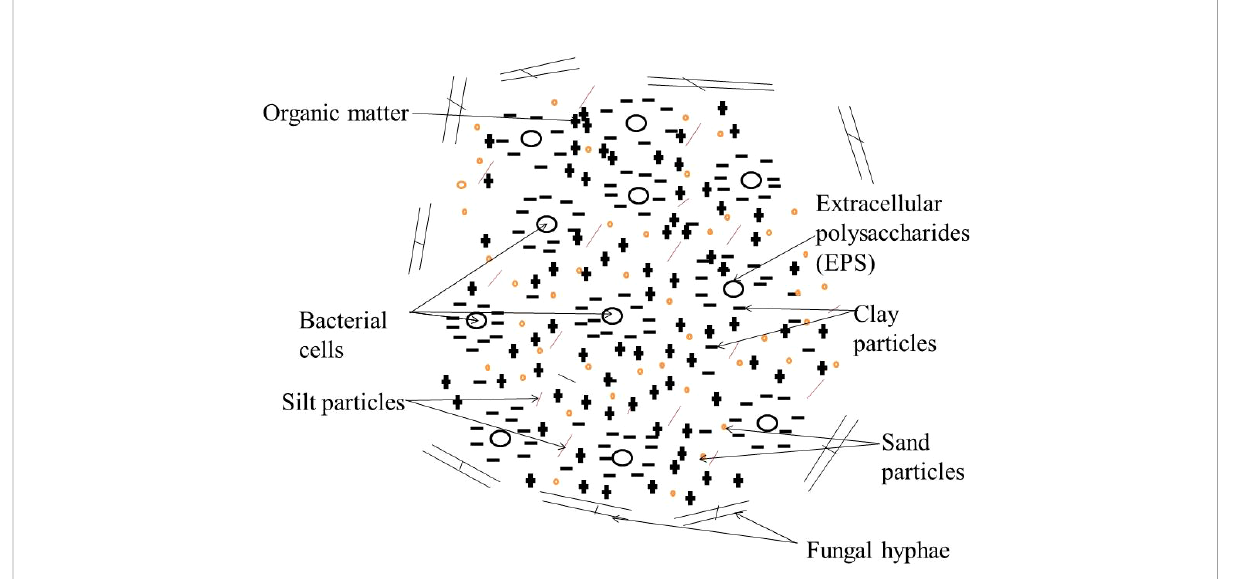
FIGURE 2 Illustration of the interaction between bioremediators with mineral particles in the soil